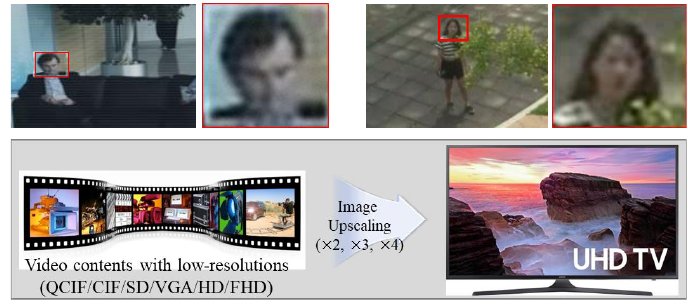
Figure 7. Applications of the image super-resolution technique.